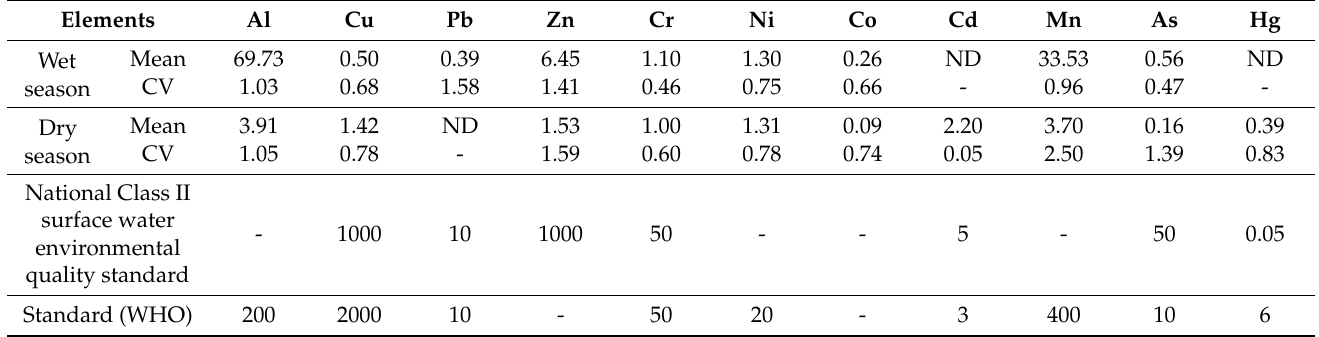
Table 3. Statistical results of surface water heavy metal(loid)s concentrations in the study